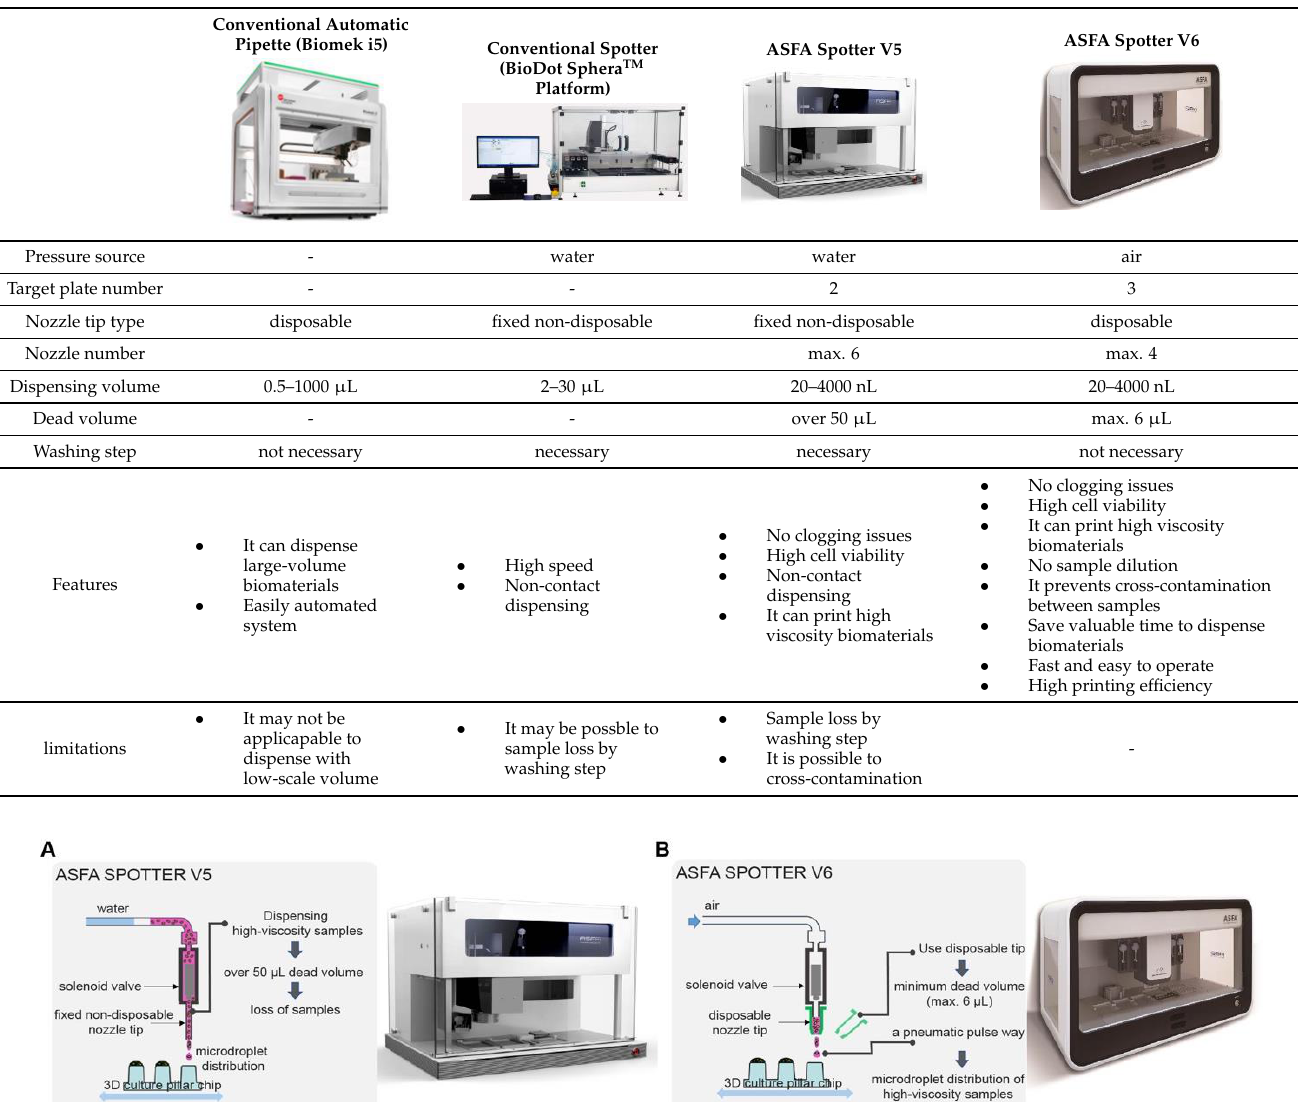
Table 1. The performance comparison between conventional dispensers and ASFA SPOTTERs V5 and V6.